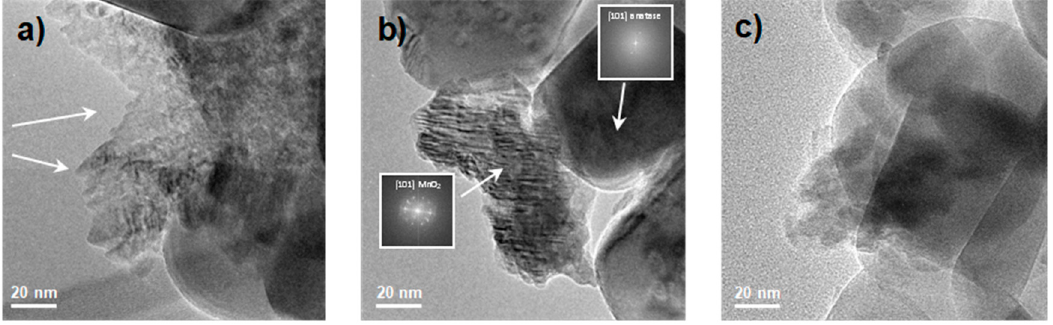
Figure 5. Transmission Electron Microscopy (TEM) images of ( a ) Mn 10 1077_4; ( b ) Mn 20 1077_4; and ( c ) Mn 20 1077_12.